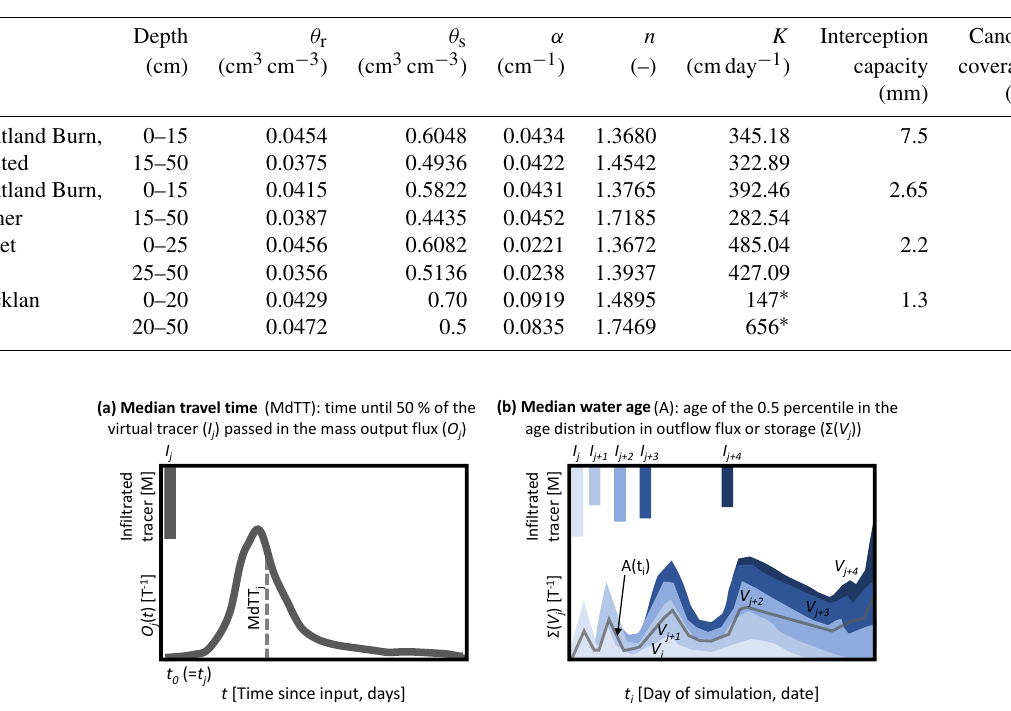
Table 1. Model parameters: depths of the soil horizons, Mualem–van Genuchten parameters ( θ r : residual water content, θ s : saturated water content, α : air entry value, n : shape parameter), saturated hydraulic conductivity K , interception capacity, and canopy coverage (Sprenger et al., 2018b).